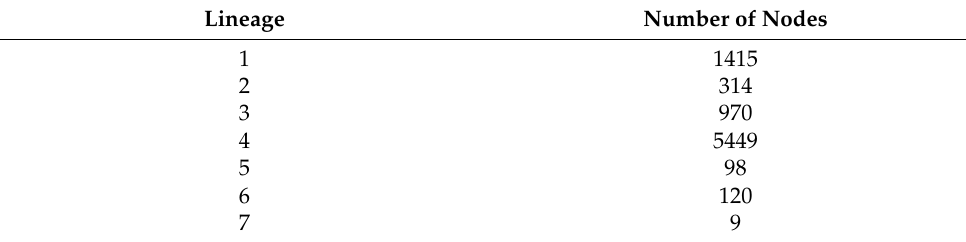
Table 1. Nodes per lineage in the